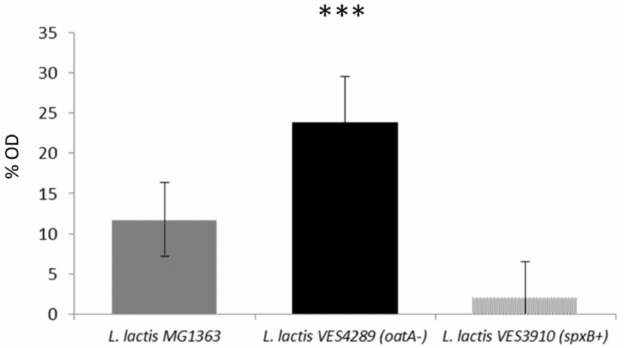
Figure 7. Endolysin LysTP712 sensitivity assay. Early exponential phase cultures (OD 600 , 0.4) of L. lactis MG1363, L. lactis VES3910 or L. lactis VES4289 growing in GM17 medium at 30 ◦ C were treated with 2.5 µ g / mL of purified LysTP712 (Fraction II) for 120 min. Columns represent the means of growth inhibition of L. lactis relative to untreated cultures ((1 − OD treated / OD untreated) × 100). Bars indicate the standard deviations. ***, p < 0,001 significantly di ff erent to L. lactis